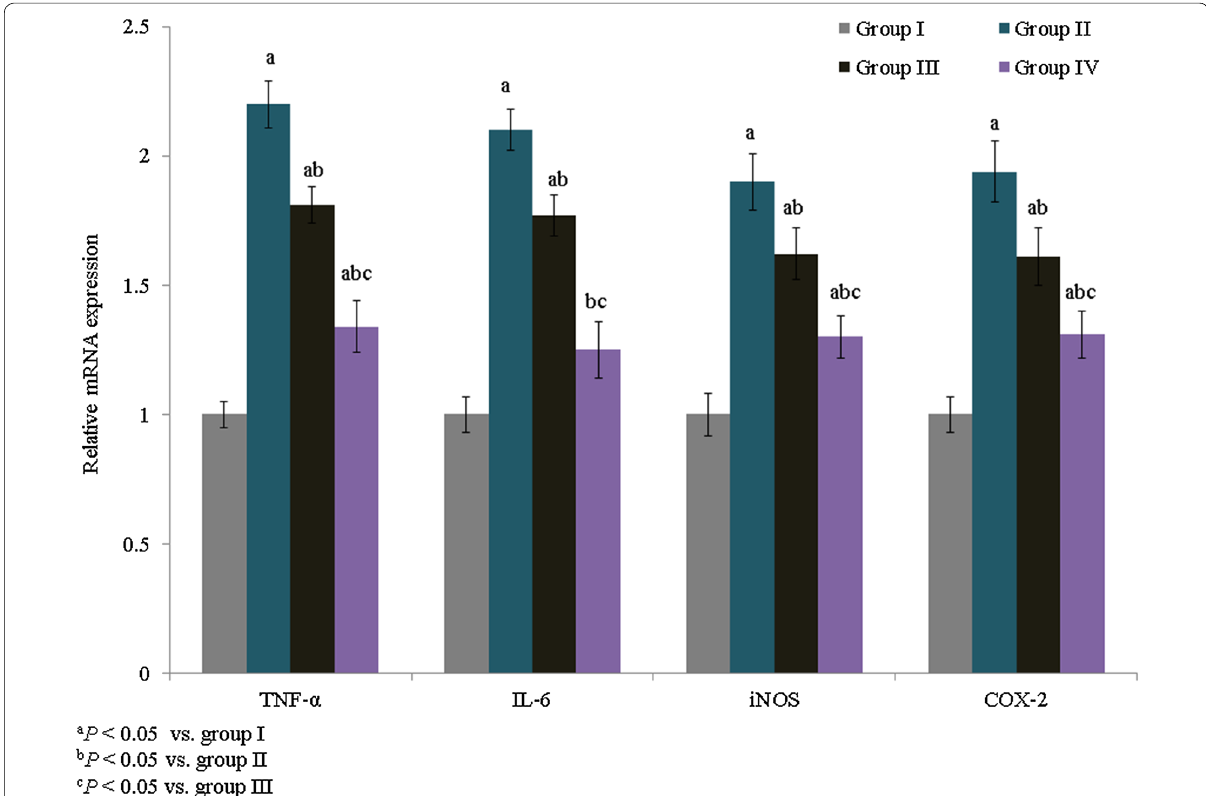
Fig. 3 Effect of E. hirta extract on the mRNA expression of TNF-α, IL-6, inducible nitric oxide synthase (iNOS), and cyclooxygenase 2 (COX-2) in neonatal asthmatic rats. Experimental data are given as the mean ±